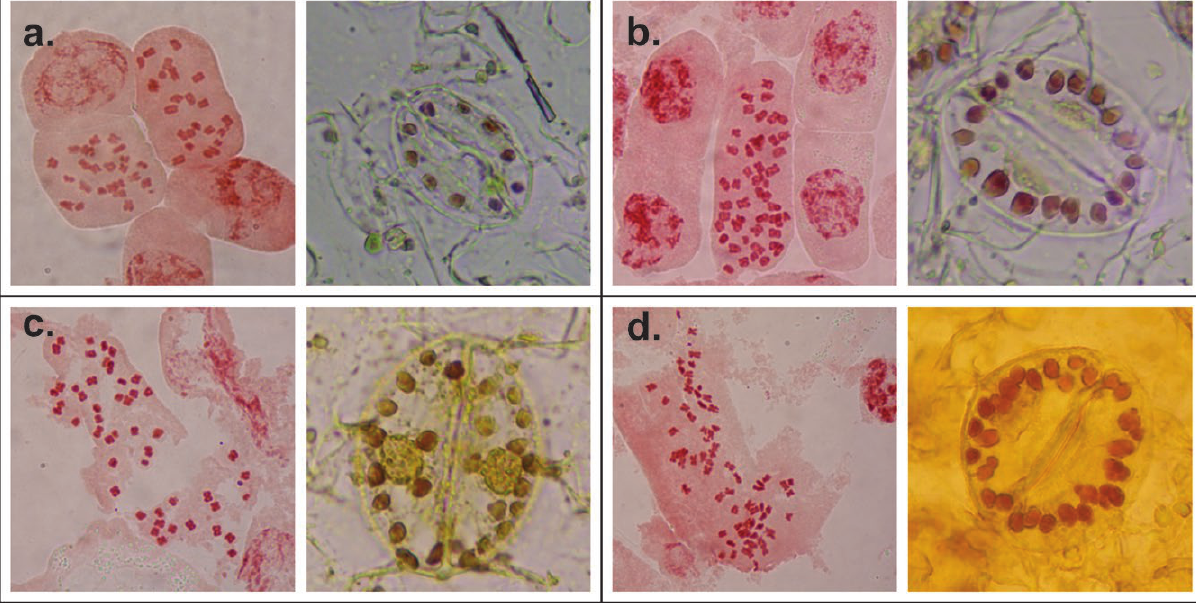
Figure. 2. Number of chromosomes and chloroplasts per guard cell from some representative genotypes of P. peruviana . A. Somatic meta- phase cell with 24 chromosomes and stomata with five chloroplasts. B. Cell with 48 chromosomes and stomata with nine and ten chloro- plasts in the guard cells. C. Cell with 49 chromosomes and stomate with 12 chloroplasts in the left guard cell. D. Cell with 69 chromosomes and stomate with 17 chloroplasts in the upper guard